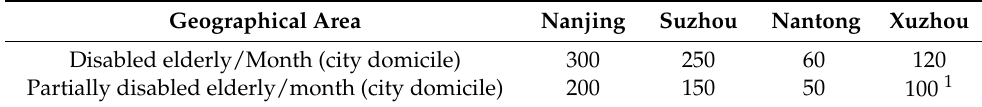
Table 4. Differences in operating subsidies in selected regions (yuan).